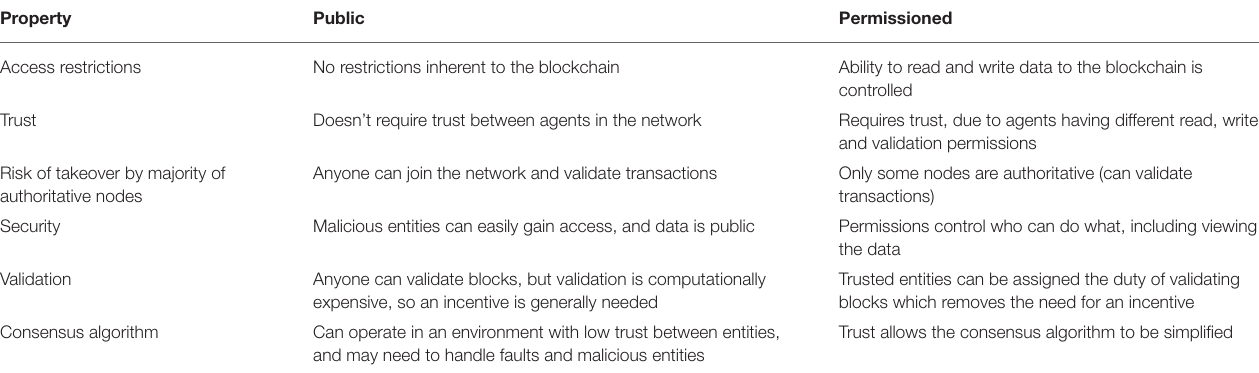
TABLE 1 | Differences between public and permissioned blockchains.